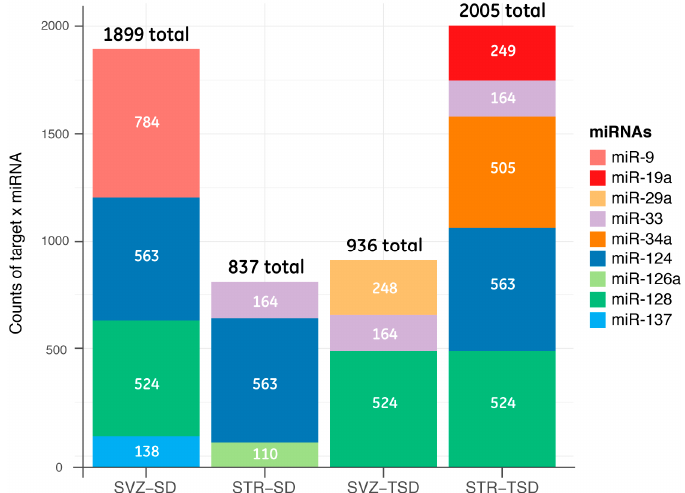
Figure 5. Counts of validated and predicted target genes for each miRNA in SVZ and STR regions of SD and TSD mice. The stacked bar plot indicates the numbers of target genes for each miRNA (color bar) within the brain regions of hex-null mice.